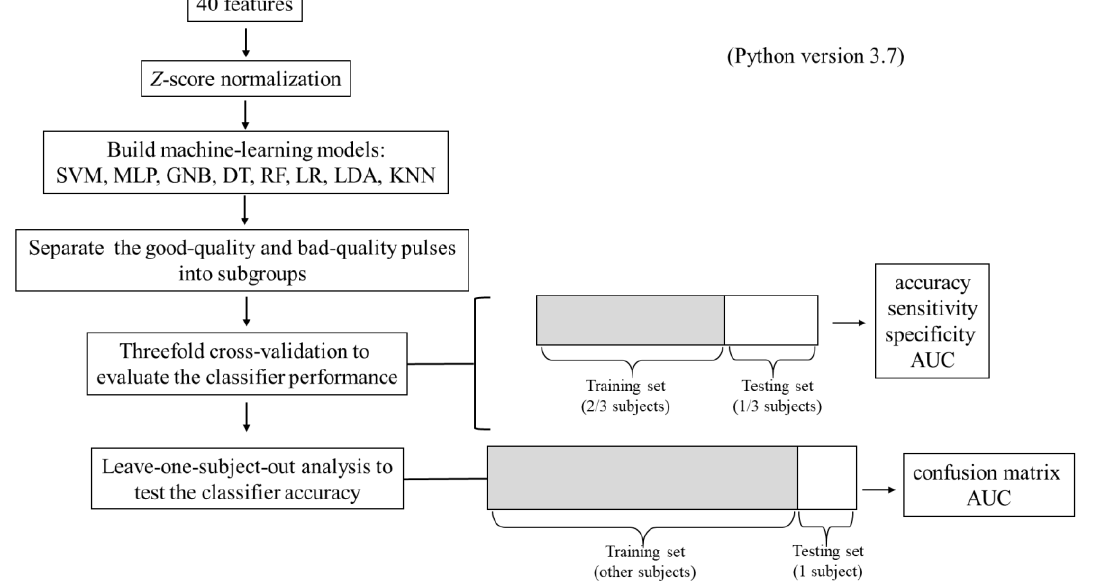
Figure 2. Flowchart of information processing in the study. Forty indices ( C n , P n , CV n , and P n _ SD ; n = 1–10) were calculated, which were used as the features for the information processing. Threefold cross-validation was used to evaluate the model performance, and then leave-one-subject-out analysis was used to test the model accuracy.